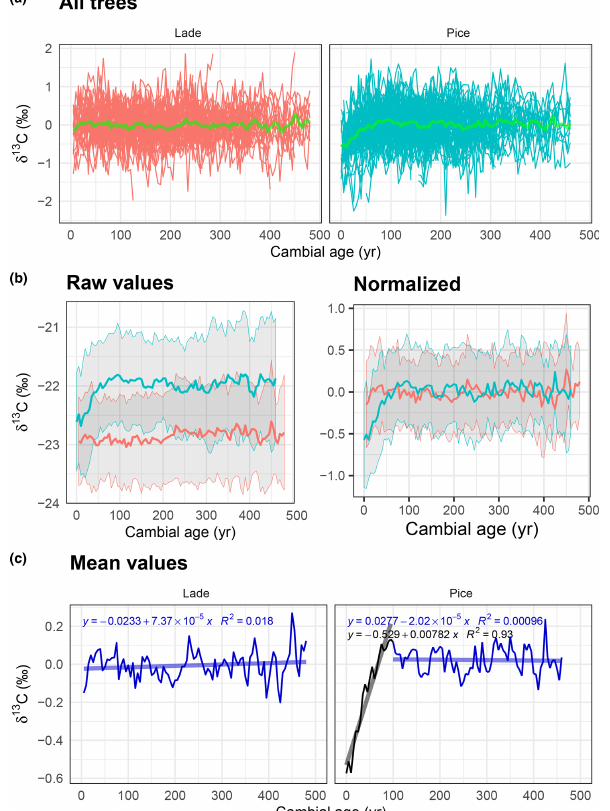
Figure 4. Analysis of δ 18 O data: (a) normalized δ 18 O values of all larch (LADE, red) and cembran pine (PICE, green) trees; the green line corresponds to the mean. (b) Raw (left) and normalized (right) mean value with corresponding ± 1 standard deviation (gray area) of larch (red) and cembran pine (cyan). (c) Plots of the mean values with linear approximations for the periods 1–50, 51–100, and > 100